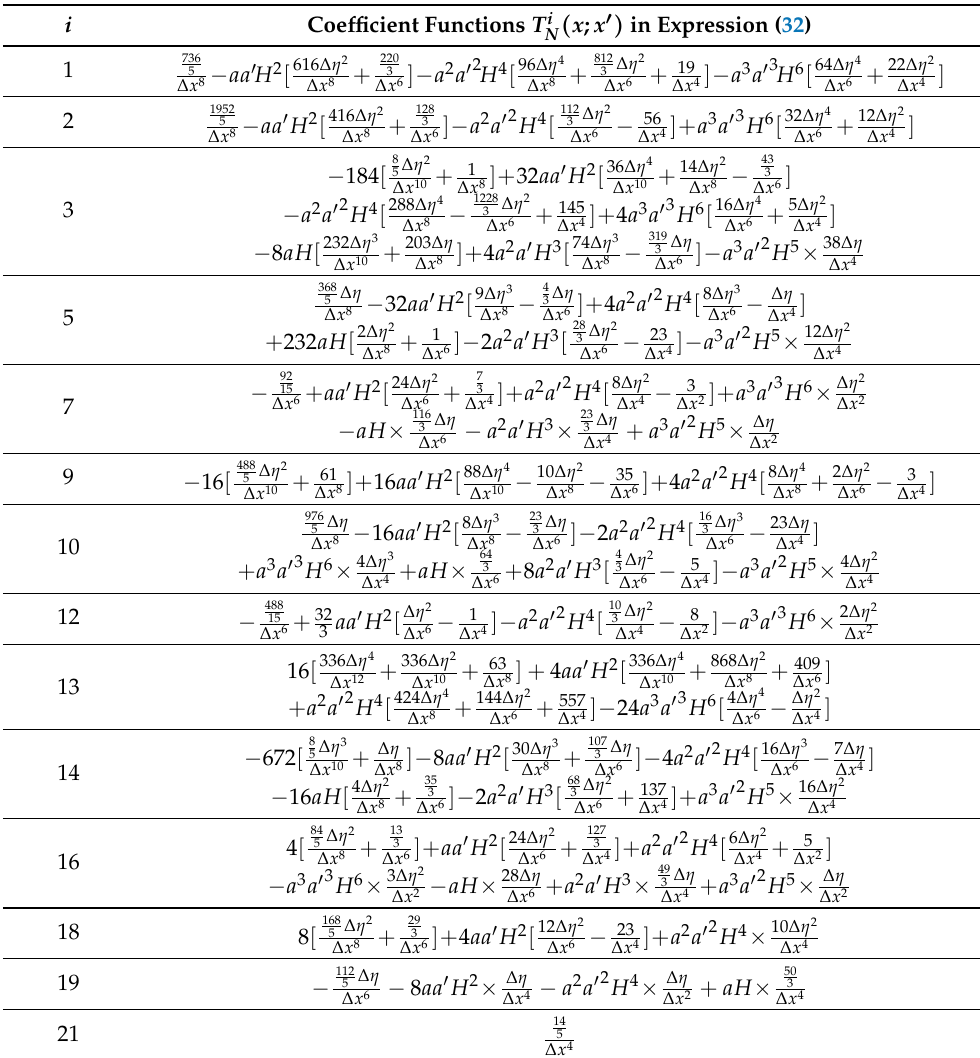
Table 4. Each of the tabulated terms must be multiplied by i Coefficient Functions T i